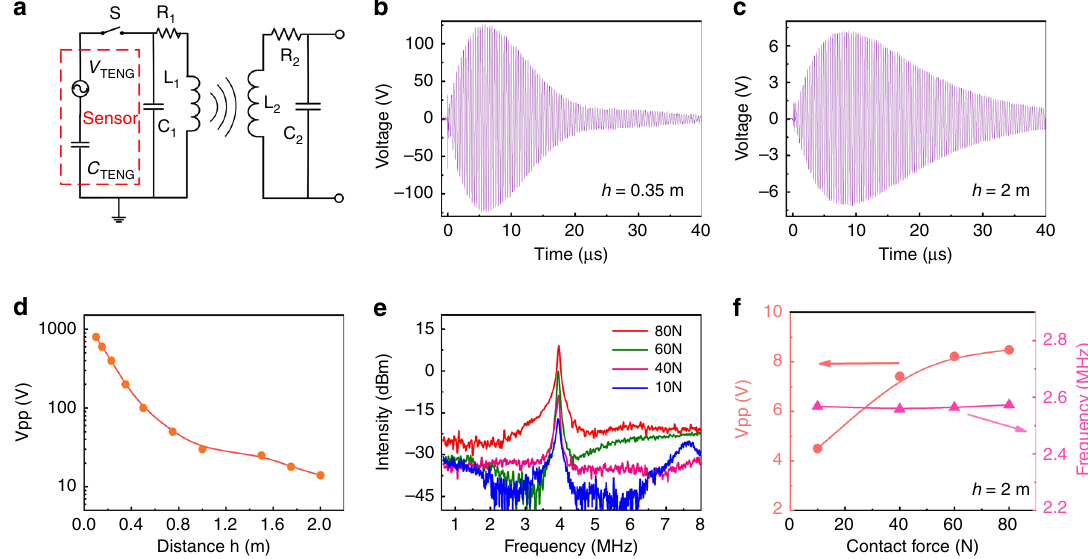
Fig. 5 Wireless signal transmission for sensing application with TENG as the sensor. a System schematic of the wireless force sensor based on TENG. b , c are the received voltage signals with a coil distance of 0.35 m and 2 m, respectively. d The summary of the peak-to-peak voltage of the received signals as a function of coil distance. e The FFT spectrum of the received voltage signal under various contact forces. f The received peak-to-peak voltage and resonant frequency as a function of contact force with a 2 m coil distance. The inner and outer diameters of the coils are 21.5 cm and 27 cm, respectively. Fig. 4f. After about tens of steps walking, the digital watch could be powered up (shown in Supplementary Movie 3).